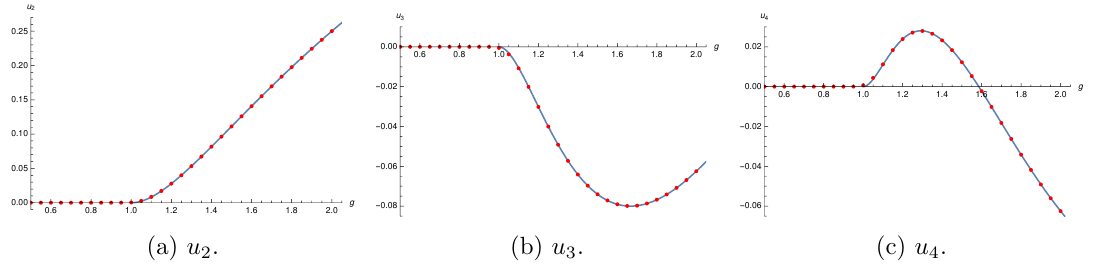
Figure 4. Plot of the expectation value of Wilson loop u 1 = 1 value for N = 100, while the blue curve and the orange curve are the planar limit (3.4) in the ungapped phase and the gapped phase, respectively.